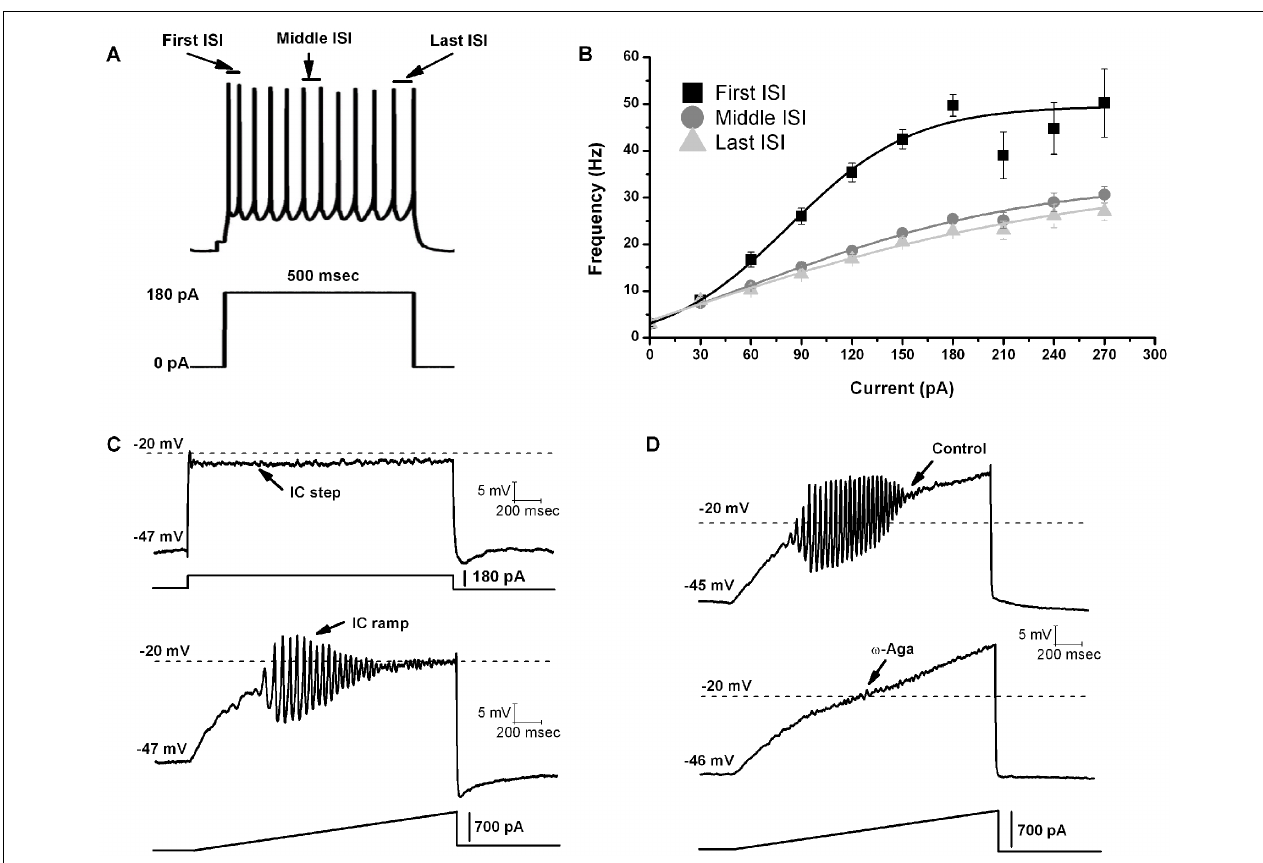
neurons. Note that the firing frequency of PPN neurons did not increase linearly but instead plateaued at gamma frequency. (C) Representative membrane potential responses to depolarizing 2s intracellular (IC) square steps (above) and responses to depolarizing 2s ramps (below) for the same neuron obtained in the presence of synaptic blockers andTTX. (D) Representative 2s long ramps before (above) and after (below) the application of ω -Aga (200nM). Note the elimination of oscillations by the P/Q-type channel blocker ω